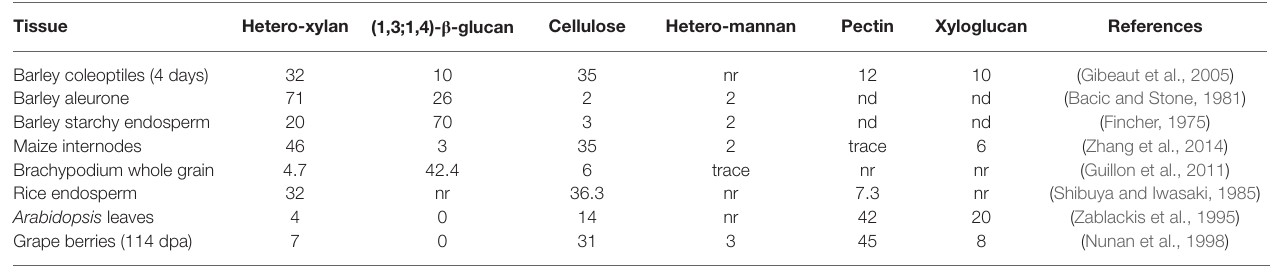
TABLE 1 | Comparison of wall composition in tissues of the grasses and